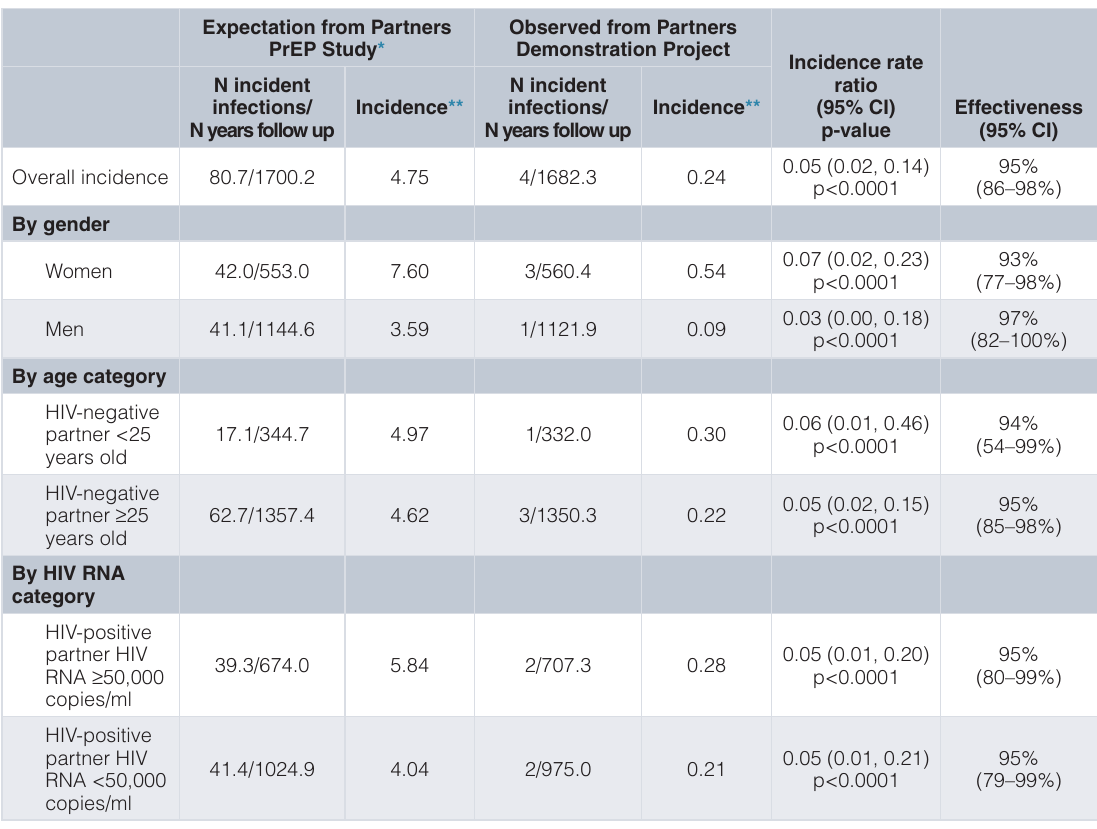
Table 2. Expected versus observed HIV